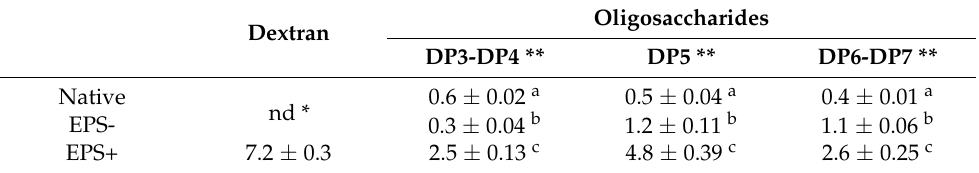
Table 4. Synthesis of dextran and oligosaccharides during fermentation of BSG with W.